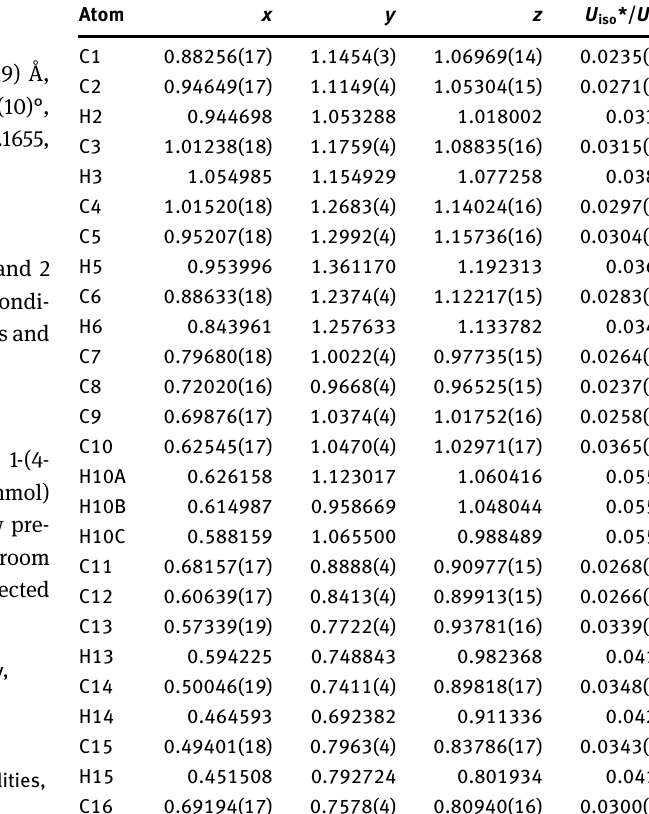
Table 2: Fractional atomic coordinates and isotropic or equivalent isotropic displacement parameters (Å 2